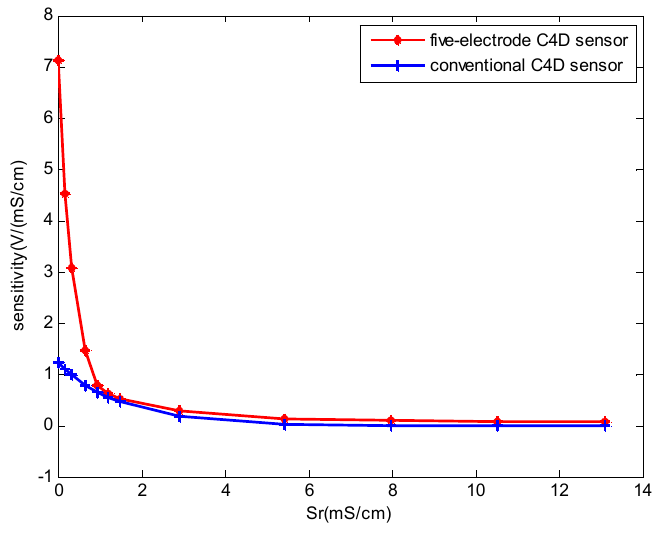
Figure 5. A typical sensitivity plot of the experiments in 0.5 mm i.d.